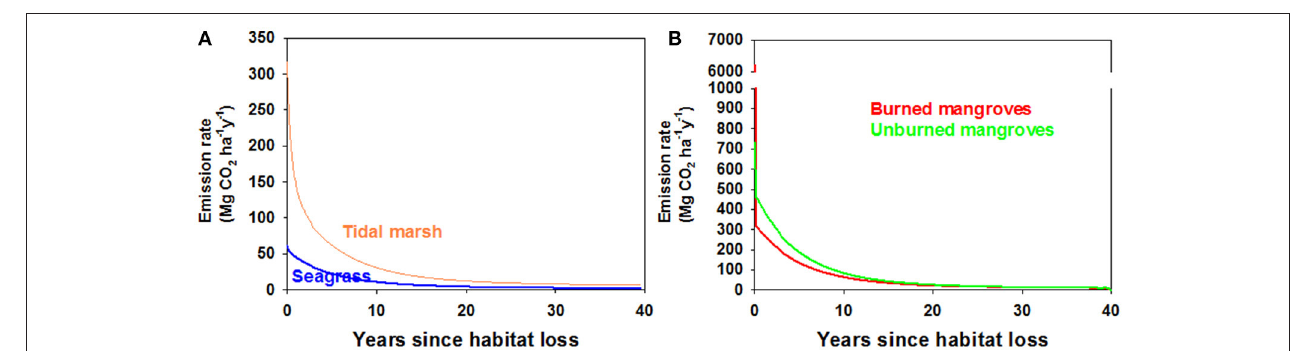
FIGURE 4 | (A) Modeled CO 2 emission rates from disturbed seagrass beds (blue) and tidal marshes (orange), with the assumption that half of the organic carbon was deposited in oxic environments (i.e., α = 0.5). (B) Modeled CO 2 emission rates from disturbed mangroves where all above-ground biomass was burned (red) or the aboveground biomass was left to decompose in situ (green). The model was run with half of the sediment organic carbon deposited in an oxic environment (i.e., α = 0.5). Note the change of scale of the Y axis to accommodate very high initial CO 2 emissions associated with burning of above-ground mangrove biomass.